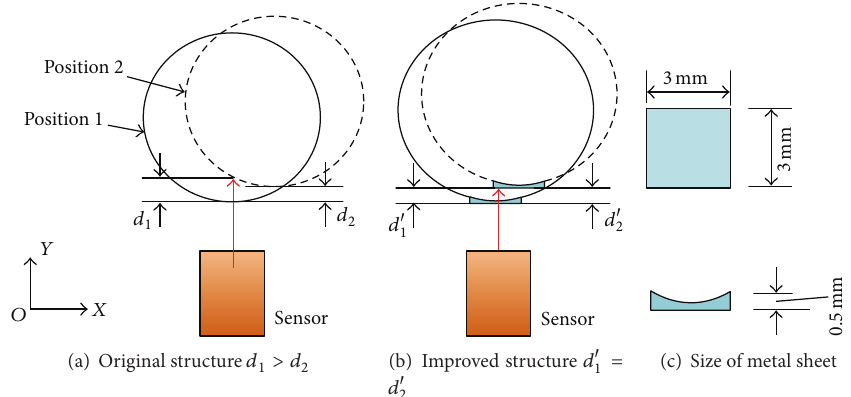
Figure 9: Schematic of improved structure.